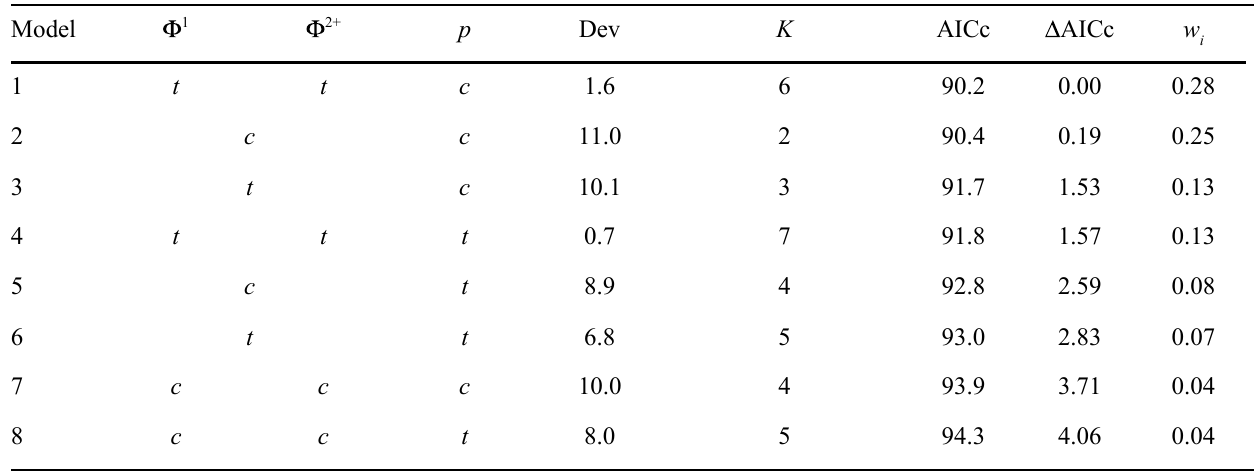
Table 3 . Comparison of Cormack-Jolly-Seber mark-resight models examining the apparent survival of individually marked females between breeding seasons ( n = 55 females). Females were marked and observed at four Greater Prairie-Chicken ( Tympanuchus cupido ) leks during a 4-year period in northeast Kansas, 2003 to 2006. Table abbreviations are as follows: 1 = apparent survival for females after initial capture; 2+ = apparent survival of females in subsequent intervals; p = probability of encounter; Dev = deviance; K = number of parameters; AICc = Akaike’s Information Criterion corrected for small sample sizes; AICc = difference of the AICc value in the given model compared to the minimum AICc model; and w weights. Model factors include: t = year and c = constant. Separate abbreviations for 1 and 2+ indicates a time-since-marking model; whereas, an abbreviation between 1 and 2+ indicates that the two classes were not modeled